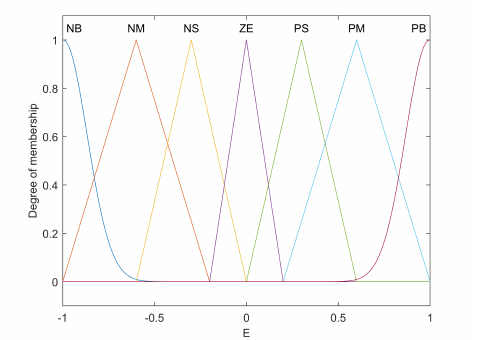
Figure 19. Inputs/Outputs E, EC and U of the modified FLC.